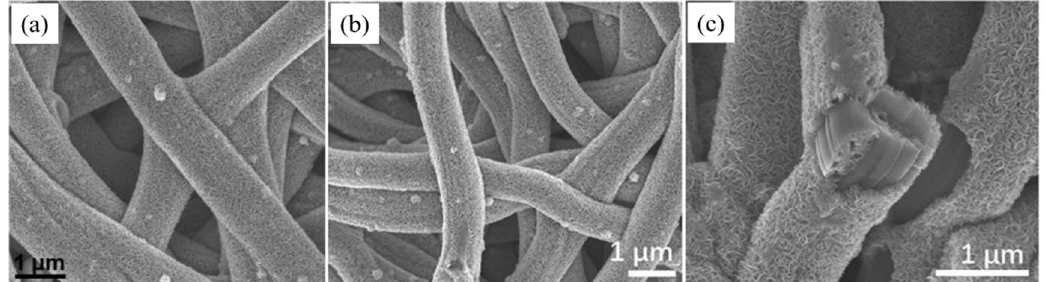
Figure 13. FESEM images of the multichannel carbon matrix (MCM)@MoS 2 nanofiber ( a ) without and ( b ) with Ni-atom modification. ( c ) The zoomed-in FESEM image of the hierarchical MCM@MoS 2 –Ni nanofiber [31].